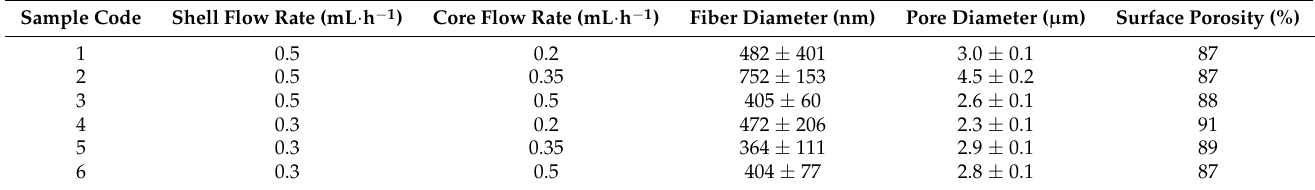
Table 1. The electrospinning condition, fiber diameter, pore diameter, and surface porosity of prepared